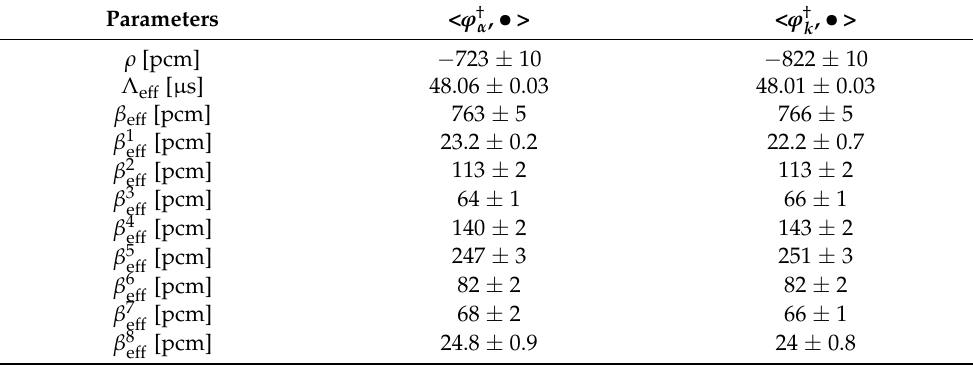
Table 20. Effective kinetics parameters for the H1 configuration including delayed contributions.